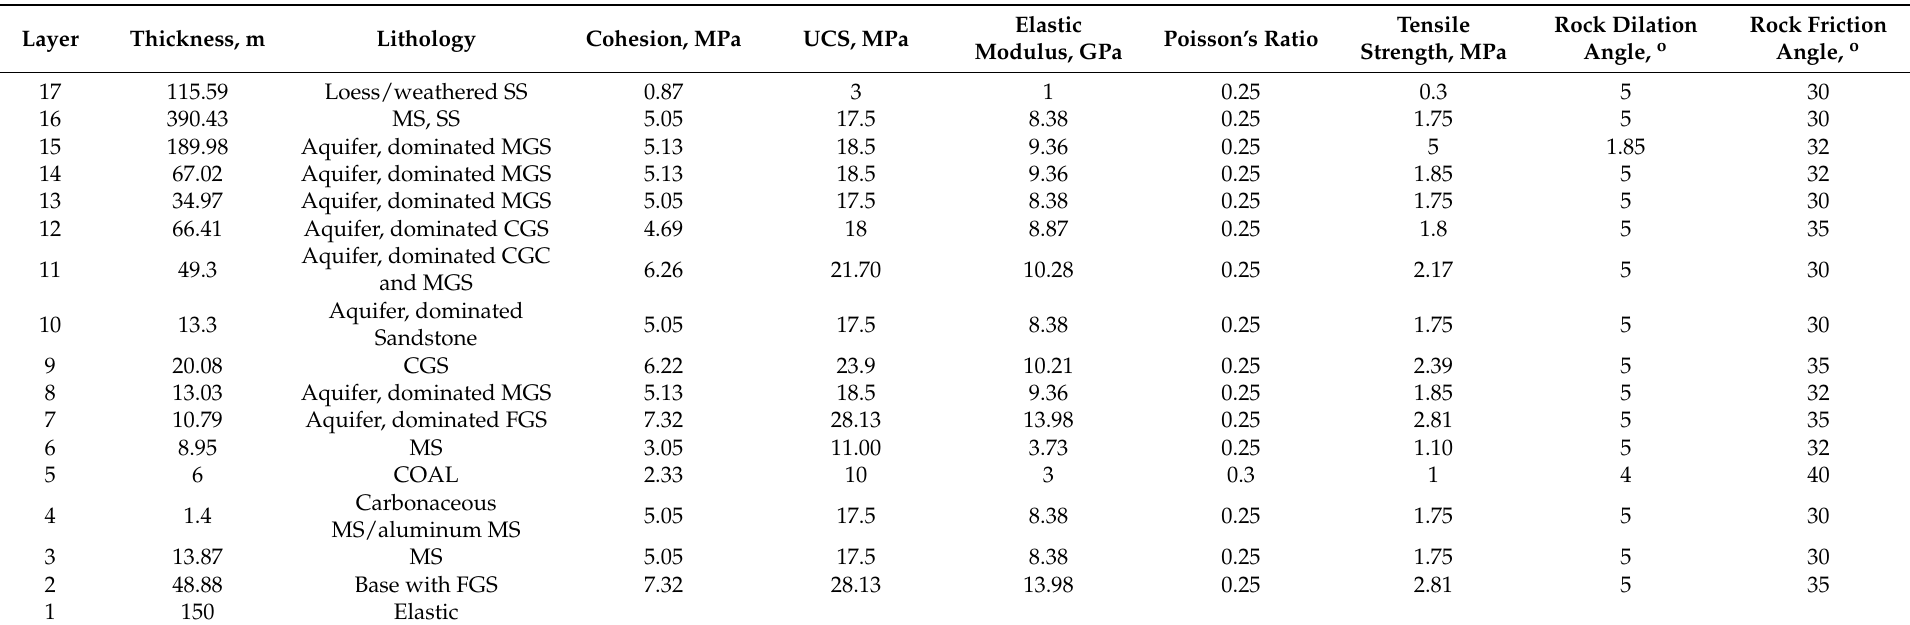
Table 2. Various strata used in the model and mechanical properties of strata interpreted from the mine measured data for the modelling purpose: SS = Sandstone; MGS = Medium Grain Sandstone; MS = Mudstone; CGC = Coarse Grain Conglomerate; GGS = Fine Grain Sandstone; CGS = Coarse Grain